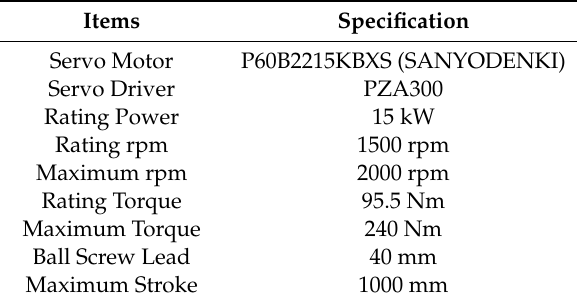
Figure 1. 6-Degree of Freedom (DOF) Sloshing Motion Platform. Table 1. Specifications of Actuator.